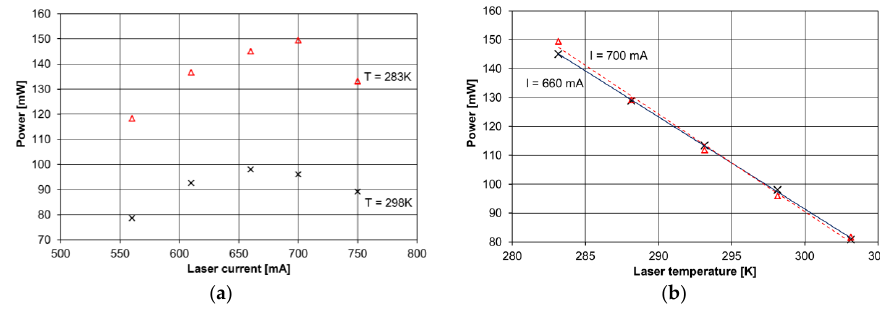
Figure 3. ( a ) Measurements results of laser current; and ( b ) temperature influence on optical power of QCL radiation.